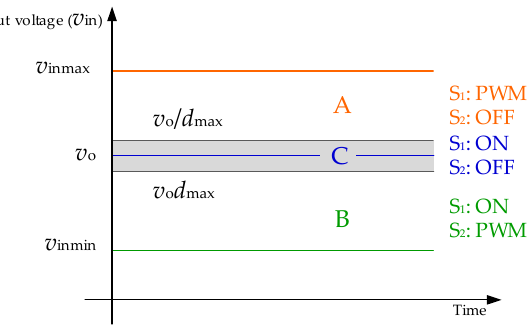
Figure 2. Operation regions of double-switch buck-boost (DSBB) converter and boundaries.